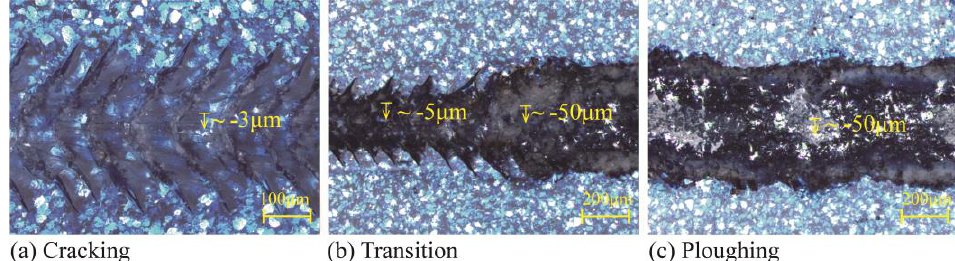
Figure 5. Typical scratch damage patterns of the automotive coating, ( a ) Cracking; ( b ) Transition; ( c ) Ploughing.